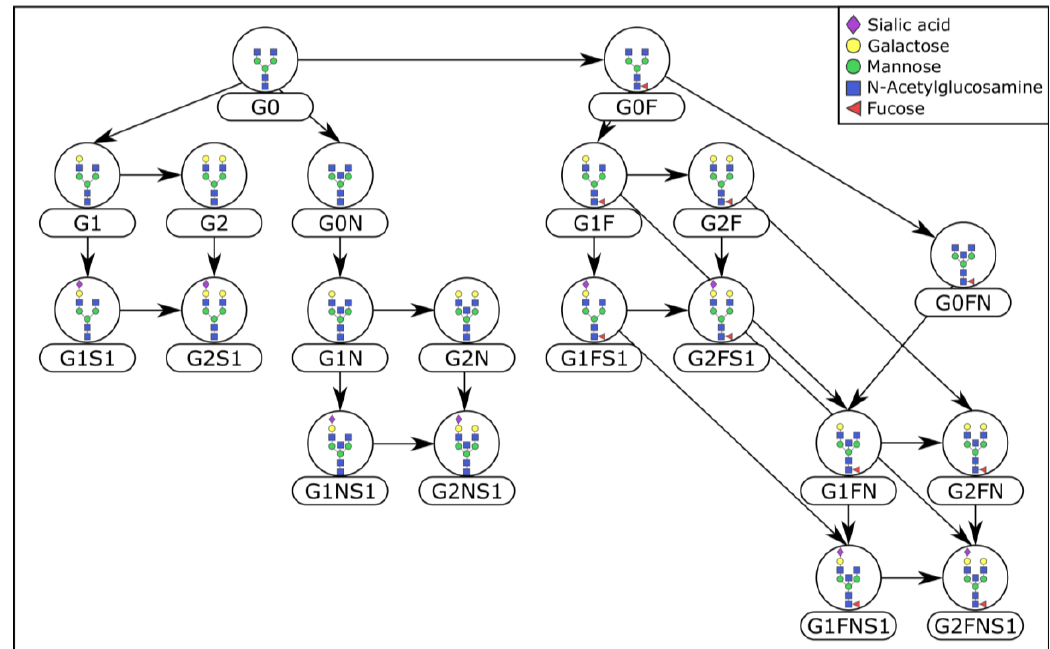
Figure 2. Reference pathway for Immunoglobulin G (IgG) Liquid Chromatography-ElectroSpray Ionization-Mass Spectrometry (LC-ESI-MS) data. IgG glycans include monosaccharides such as mannose, N-acetylglucosamine, galactose, fucose, and sialic acid, and are synthesized by the incremental addition of single monosaccharides.